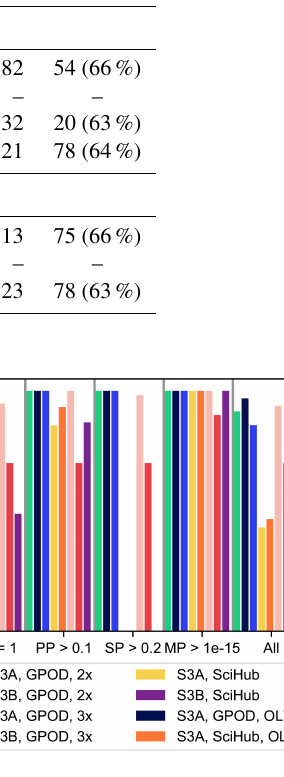
Figure 4. Stations fulfilling the Level-1b (L1b) selection criteria in percentage of virtual stations (VSs) selected based on Level-2 data. Note that ESA SciHub does not provide the waveform in power; therefore, the stack peakiness (SP) and maximum power (MP) are not calculated and are not part of the “all criteria fulfilled” evalu- ation. OLTC indicates the waveform statistics after the Open-Loop Tracking Command (OLTC) update on Sentinel-3A in March